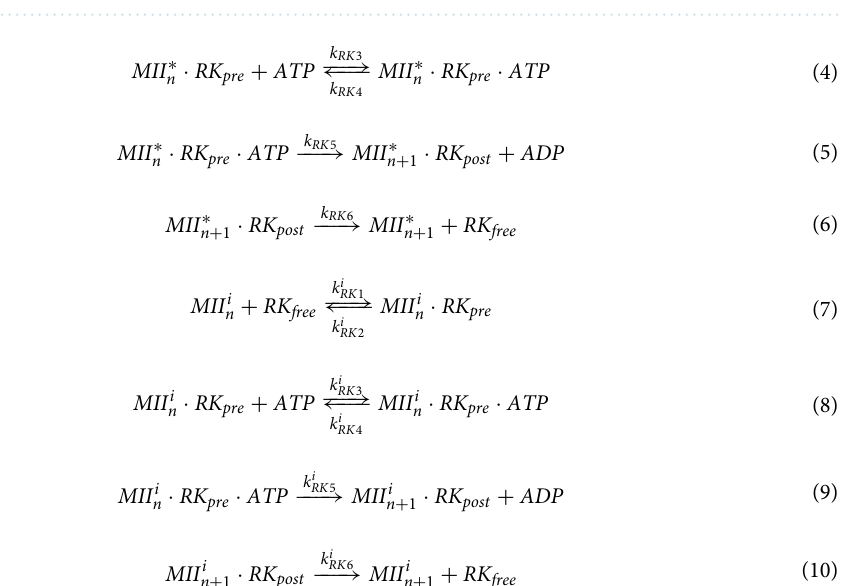
Table 2. Abbreviations in model